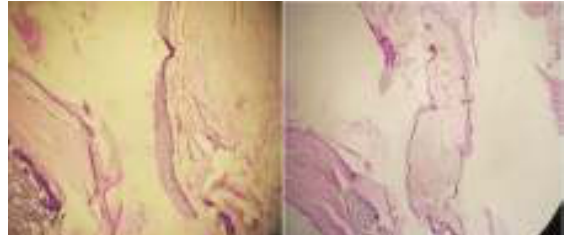
Figure 3 . Pathology findings of the cystic lesion